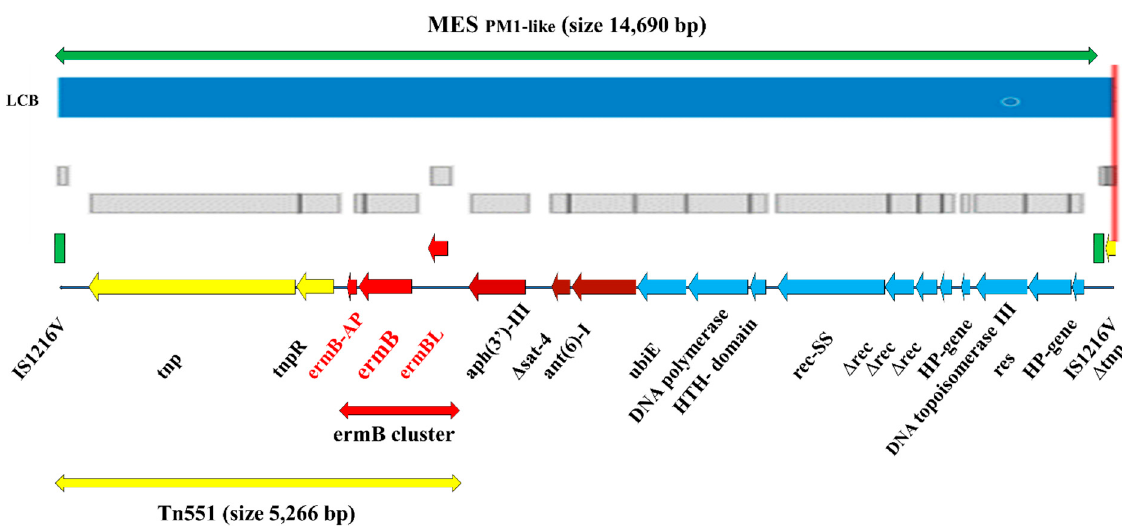
Figure 4. Genetic structure and organization of MES PM1-like in genome of SO574/12 strain. MES— chromosomal mobile element structure; LCB—locally collinear block; IS1216V—insert on sequence IS1216V; tnp —transposase of Tn551 gene; tnp R—DNA-invertase gene; erm B-AP— erm B-associated